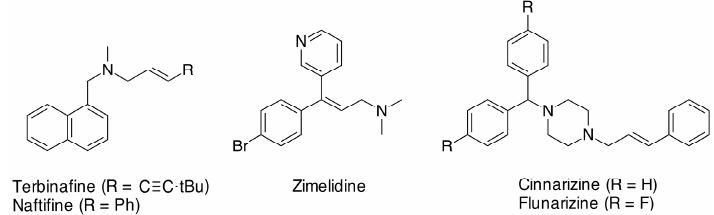
Figure 1. Bioactive compounds based on the allylamine structure.